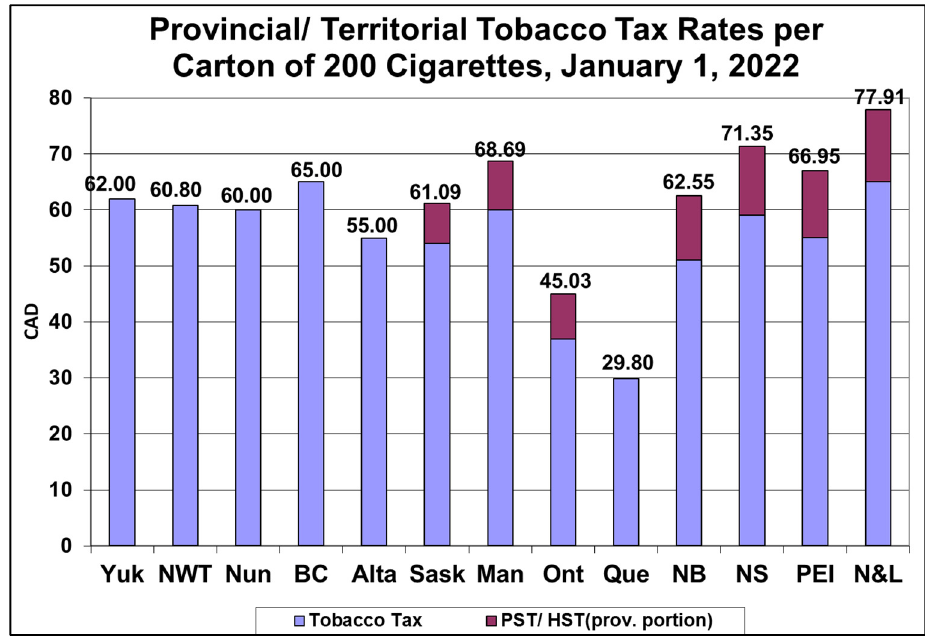
Figure 3. Provincial/territorial tobacco tax rates in CAD. Table 2. Cigarette tax and price increases per province/territory, 2014–2021 (first half) inclusive .